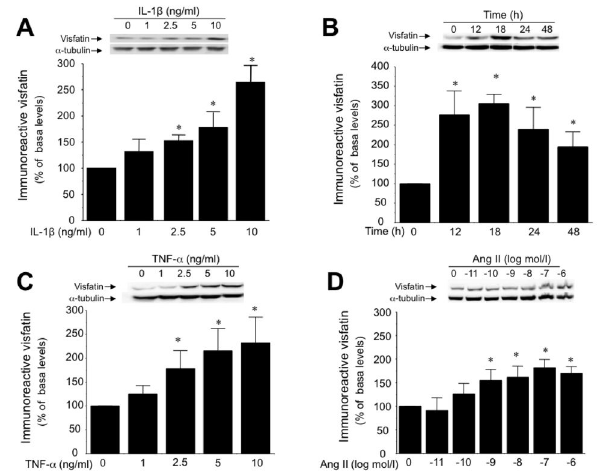
Figure 1. Inflammation enhances intracellular